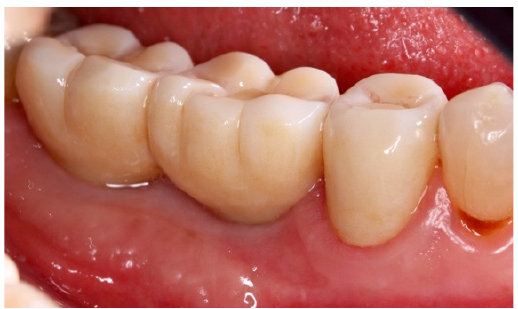
Figure 12. Prosthetic finalization of the case and mucose quality.